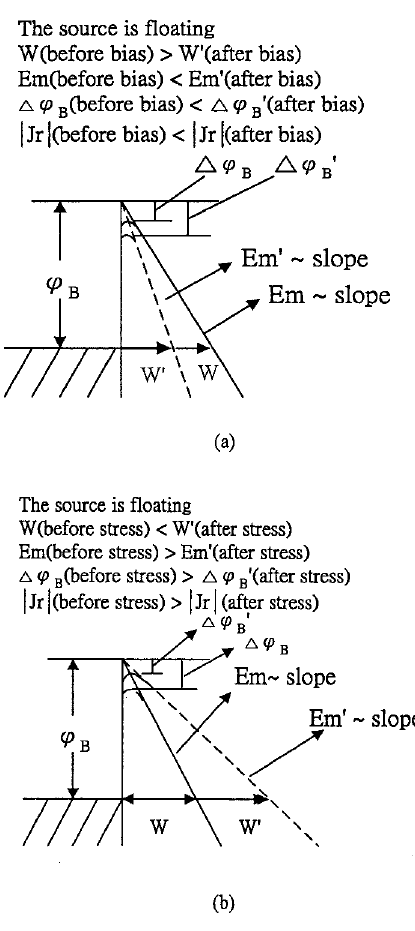
FIGURE 6 (a) Triangular barrier approximation for a metal–semiconductor barrier, before (solid line) bias and after (dashed line) reverse bias. The source is floating. (b) Triangular barrier approximation for a metal– semiconductor barrier, before (solid line) and after (dashed line) stressing. The source is